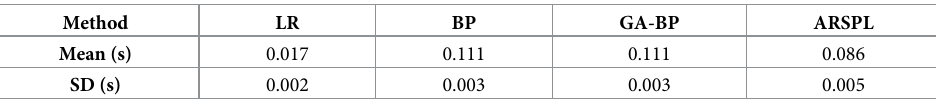
Table 6. Reconstruction time of the four methods in the best